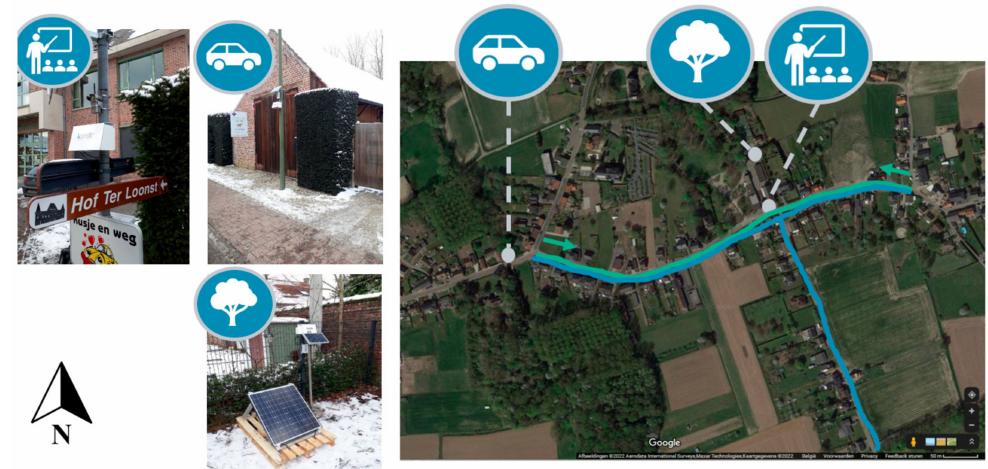
Figure 2. Monitoring locations (school, environment (car), background (tree)) of the Kampenhout pilot, with associated visualizations of the Kunak and Airly